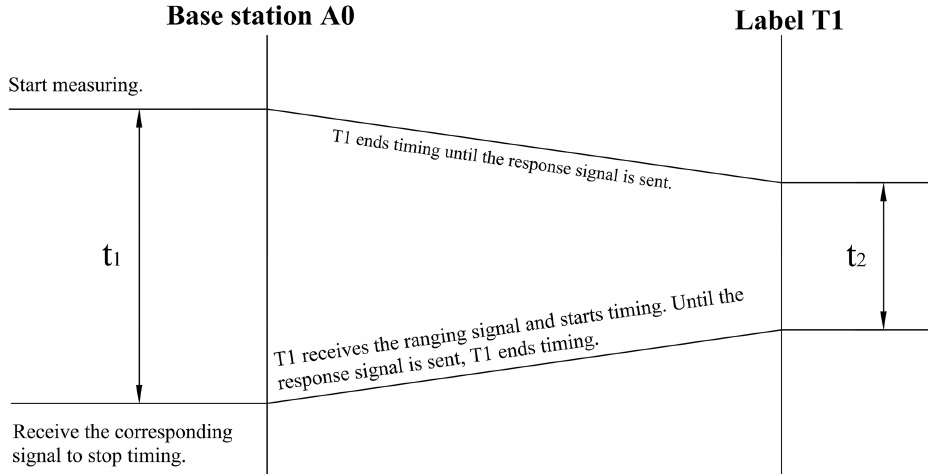
Figure 7. Schematic of the two-way ranging method.